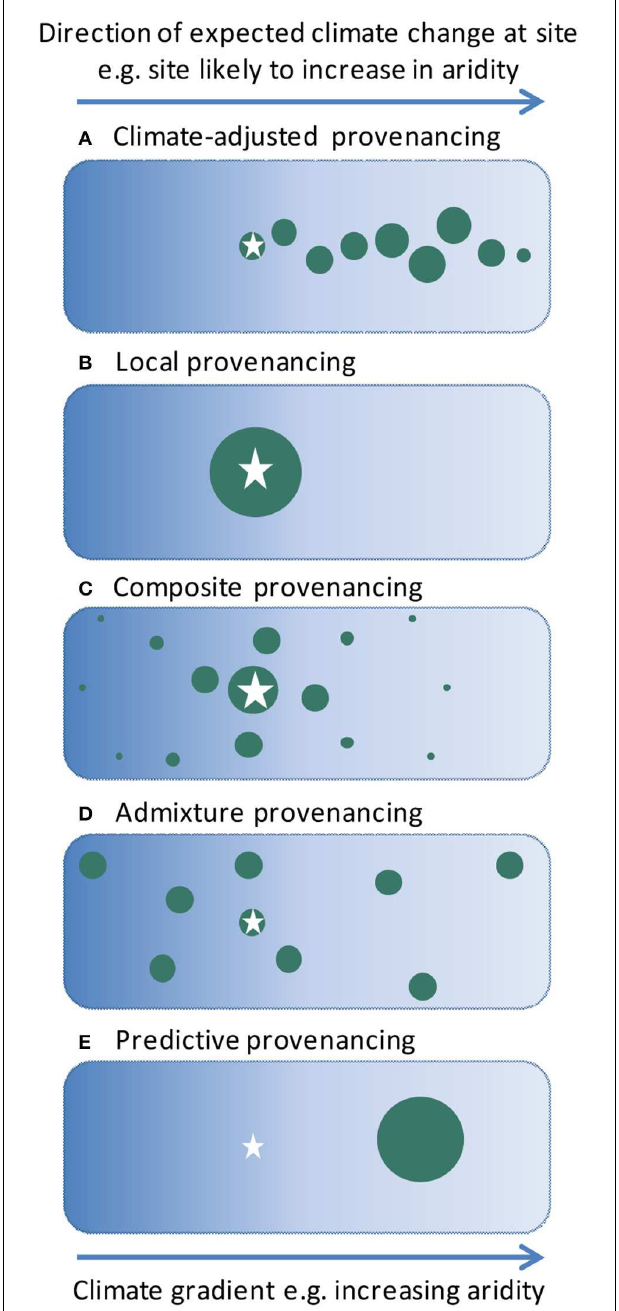
FIGURE 1 | Diagrammatic representations of provenancing strategies for revegetation, modified from Byrne et al. (2013). The star indicates the site to be revegetated, and the green circles represent native populations used as germplasm sources. The size of the circles indicates the relative quantities of germplasm included from each population for use at the revegetation site. In the case of the climate-adjusted provenancing the relative quantities of the germplasm from the various populations will depend upon factors such as genetic risks, and the rate and reliability of climate change projections. For simplicity we represent the major direction of climate change in a single dimension (e.g., aridity, to combine influences of increasing temperature and decreasing rainfall), but multiple dimensions could be considered as